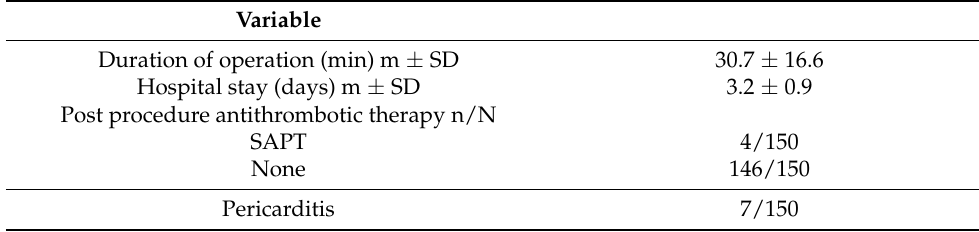
Table 2. Intra-post operative data, pharmacological